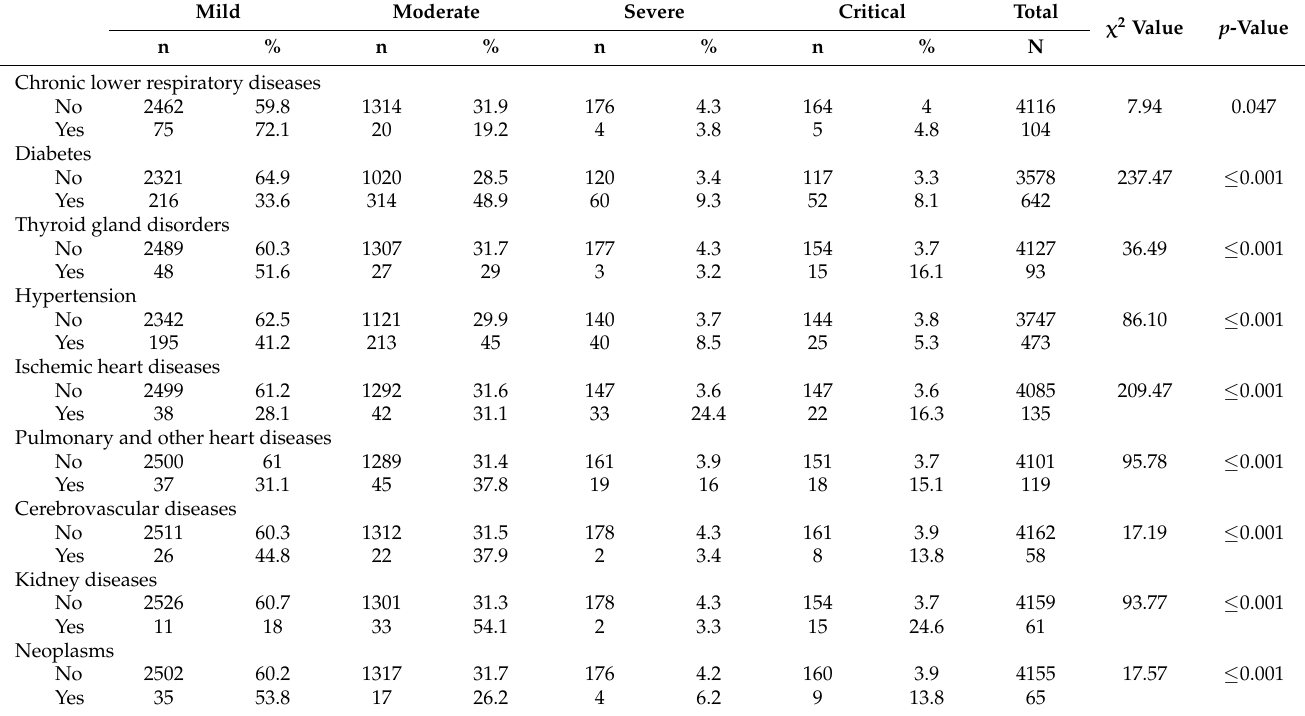
Table A2. Chi-square test for association between co-morbidities and COVID-19 severity, N =